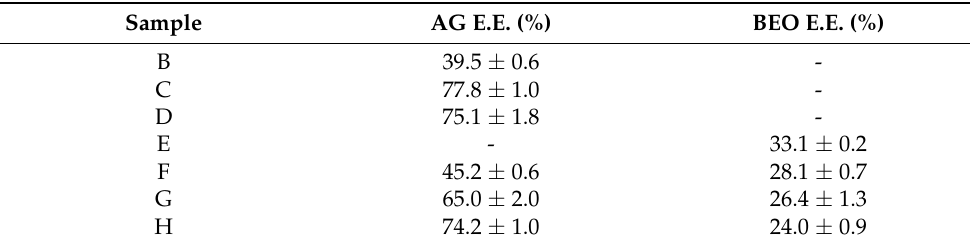
Table 3. Entrapment efficiency (E.E.) of the different vesicular formulations.